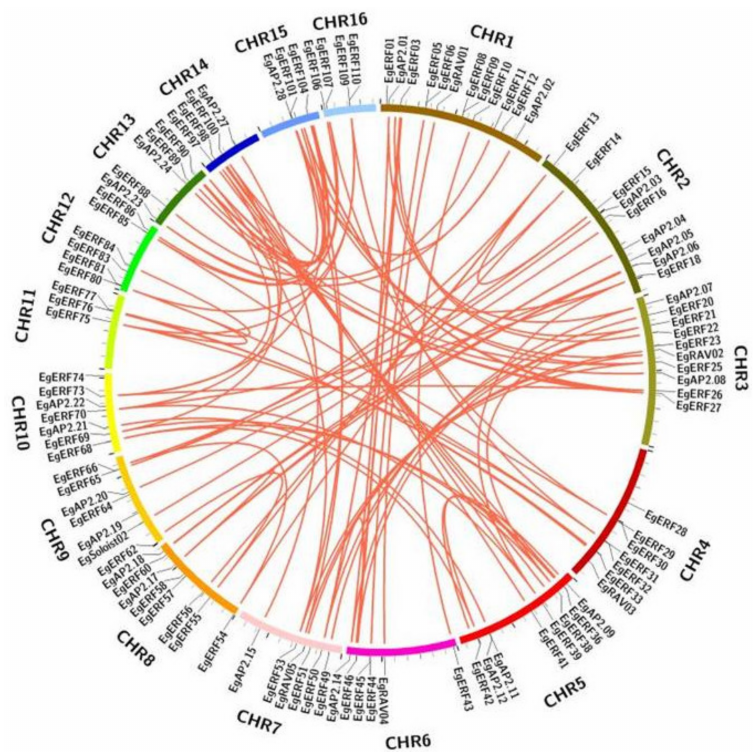
Figure 4. Schematic interpretation of AP2, ERF, RAV , and Soloist genes’ duplication in the oil palm genome. Each chromosome block is denoted with a different color. Red lines inside the schematic view denote the duplicated gene pairs of oil palm AP2/ERF s.